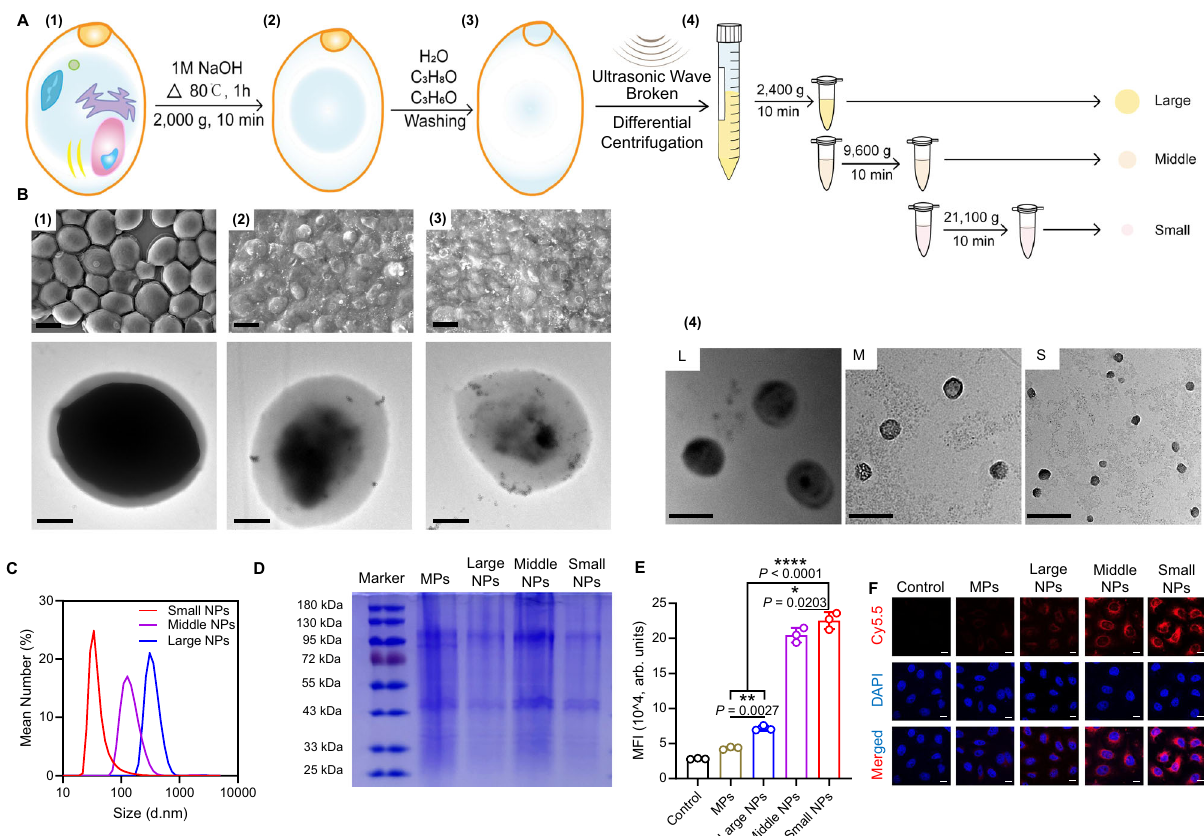
Fig. 1 Preparation and characterization of YCW particles. A Schematic of preparation of YCW nanoparticles (NPs). B SEM and TEM images of every procedure from yeast to different size of YCW NPs. Upper left: SEM image of procedure (1) – (3), Scale bar = 3 μ m. Bottom left: TEM image of procedure (1) – (3), Scale bar = 1 μ m. Right: TEM image of procedure (4) (three different sizes of YCW NPs), Scale bar = 500 nm. C Distribution of three different sizes of YCW NPs observed by DLS. D SDS-PAGE of YCW particles, including MPs (micro-particles), Large NPs, Middle NPs and Small NPs, using Coomassie Brilliant Blue Staining. E The corresponding quanti fi cation of Cy5.5 (MFI) after DC2.4 incubation with Cy5.5-labelled particles for 24 h ( n = 3, n means the number of samples included in an individual experiment). F Confocal imaging of Cy5.5-labelled YCW particles with different sizes after incubation with DC2.4 for 24 h (blue: DAPI; red: Cy5.5; Scale bar = 10 μ m, n = 3). All experiments were run in triplicate. Statistical signi fi cance between different groups was obtained by one-way ANOVA using the Tukey post-test. **** P < 0.0001; ** P < 0.01; * P < 0.05. Data are means± SD. YCW: yeast cell wall, SEM: scanning electron microscopy, TEM: transmission electron microscopy, DLS: dynamic light scattering, MFI: mean fl uorescence intensity, arb. units: arbitrary